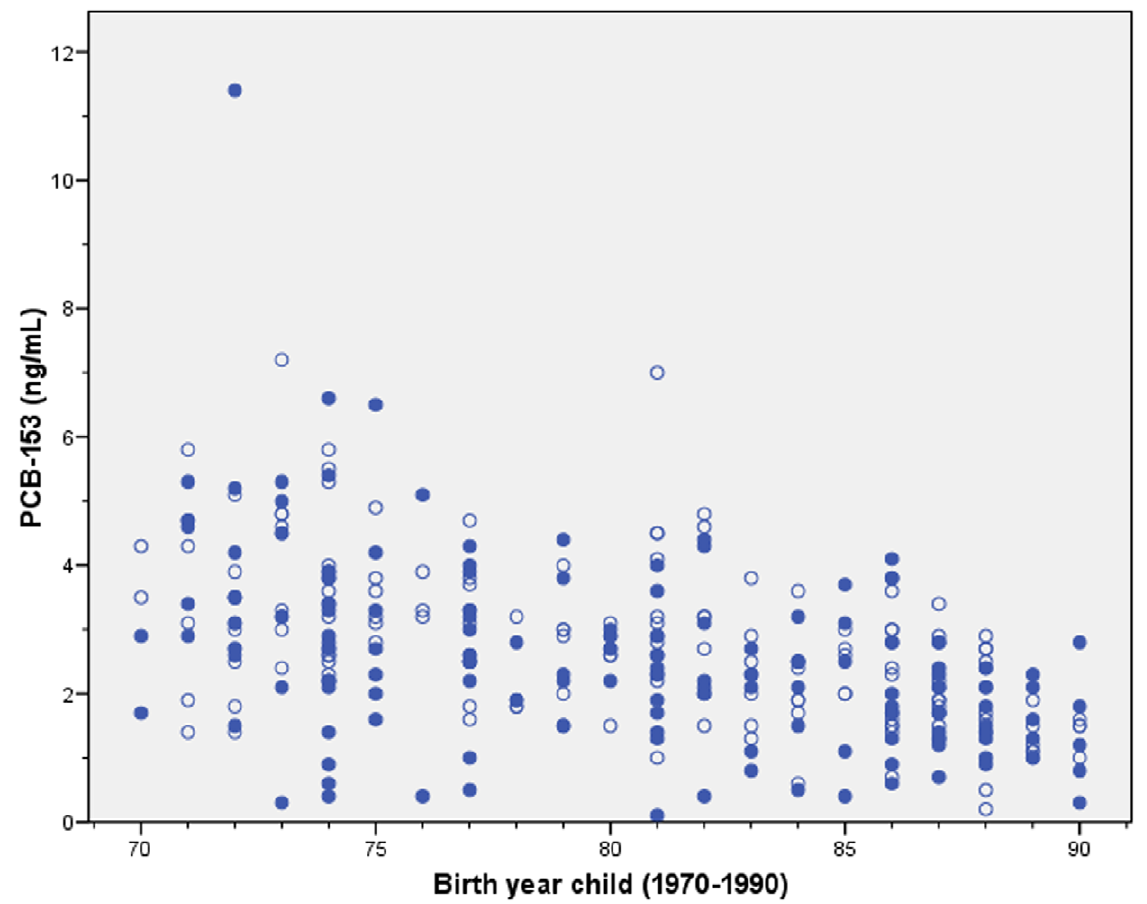
Figure 1. The median maternal serum concentrations of PCB-153 from 1970–1990.